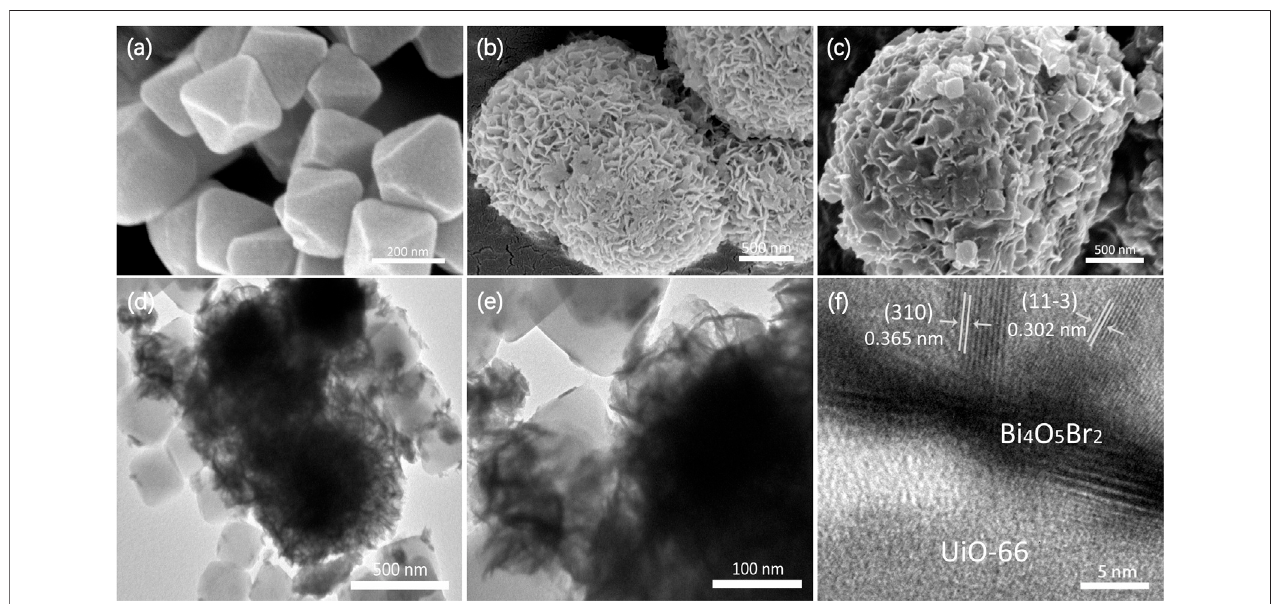
FIGURE 3 | FESEM images of (A) UiO-66, (B) Bi 4 O 5 Br 2 , (C) U@B-10, (D – E) TEM of U@B-10, and (F) HRTEM of U@B-10.